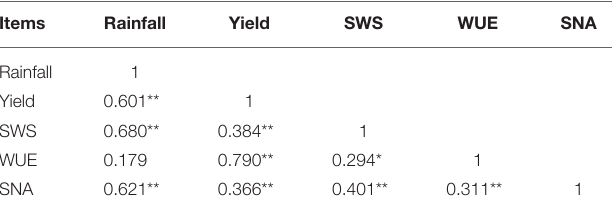
TABLE 5 | Pearson correlations of soil water storage (SWS) before sowing and soil